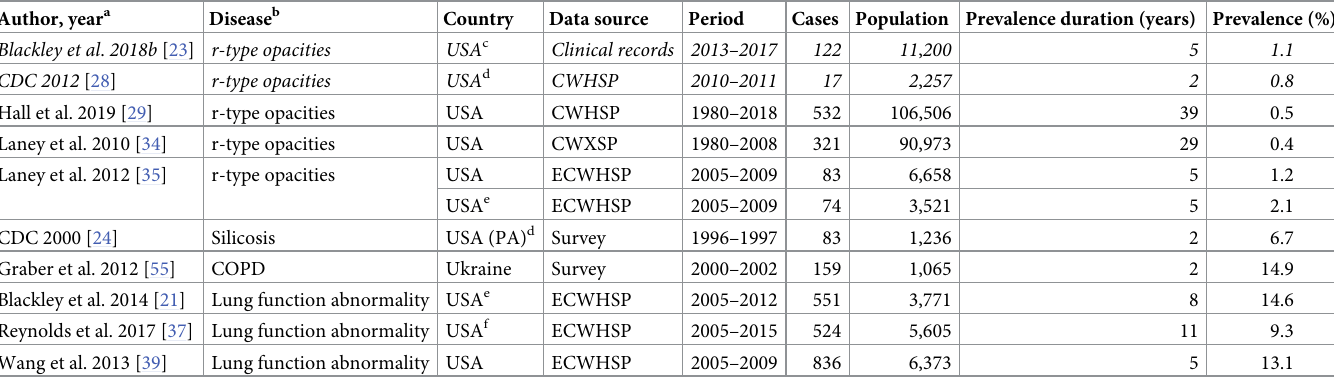
Table 6. Summary of included studies on prevalence of other coal mine dust lung disease. Author, year